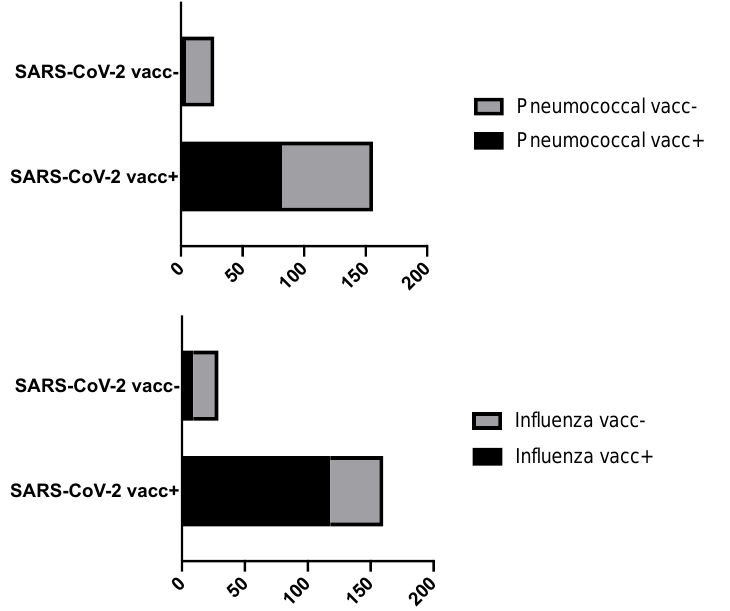
Figure 1. Vaccination coverage for SARS-CoV-2 is increased in patients with both current influenza and pneumococcal